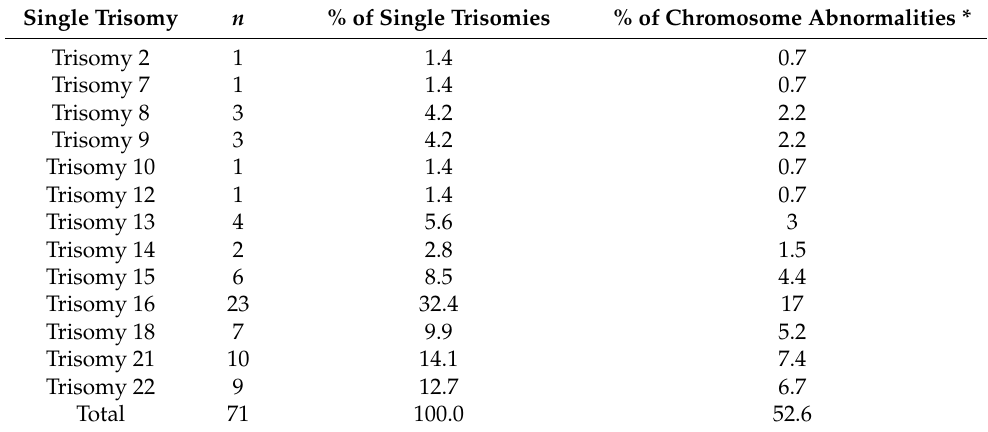
Table 2. Chromosome involvement in all single trisomies